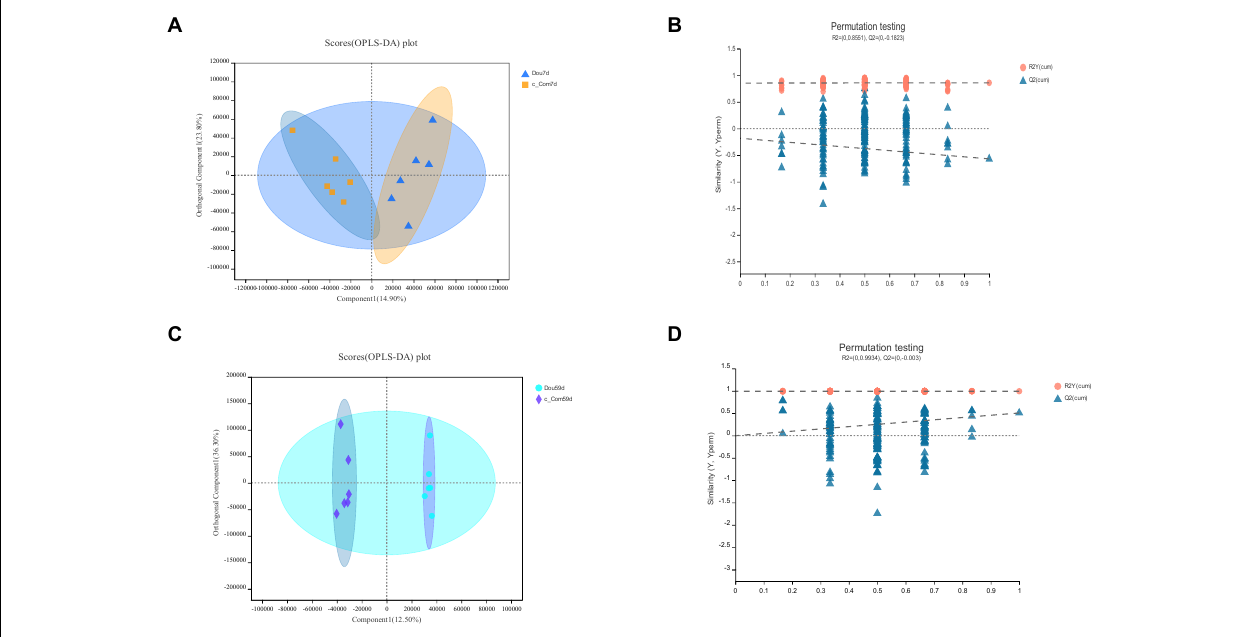
FIGURE 6 | In c-Com vs. Dou, panels (A,B) for 7th day and panels (C,D) for 59th day. Panels (A,C) are OPLS-DA scores plot. Panels (B,D) are OPLA-DA permutation tests. (B) R 2 X (cum) = 0.388, R 2 Y (cum) = 0.86, Q 2 = − 0.57. D: R 2 X (cum) = 0.787, R 2 Y (cum) = 0.993, Q 2 = 0.506.